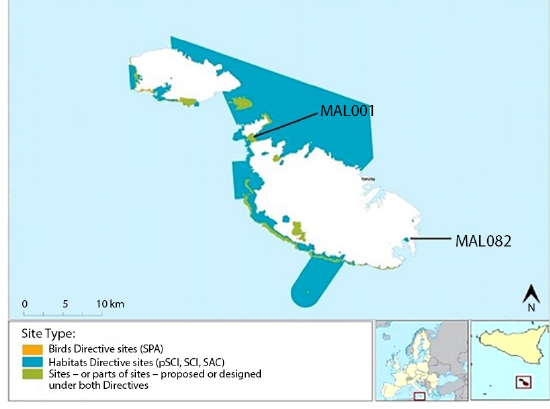
Figure 1. The territorial scope of of Natura 2000 sites (Bird and Habitats Directives) in Malta with locations of evaluated PAs. Adapted from: European Environment Agency